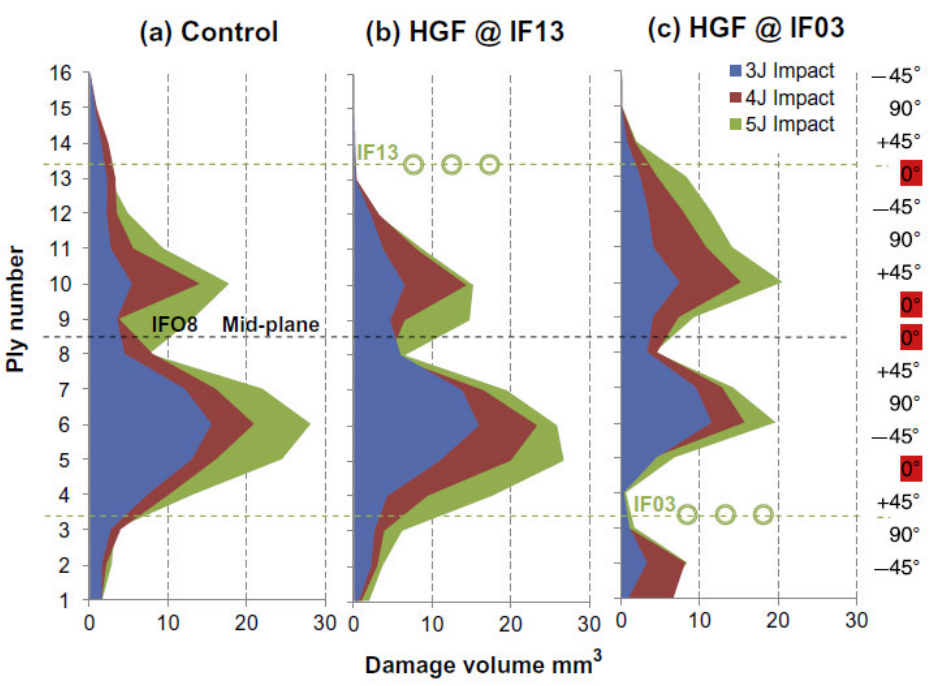
Figure 13. Mean damage volume per ply for ( a ) the control, ( b ) the HGF@IF13, and ( c ) the HGF@IF3 specimens impacted at 3, 4, and 5 J on ply 16. Reproduced from [139] with permission from Else- vier.